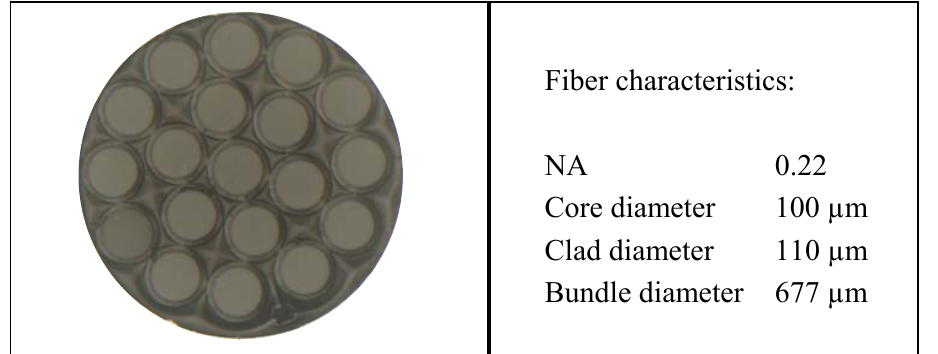
Figure 2. Microscope image of the cross-section of the common